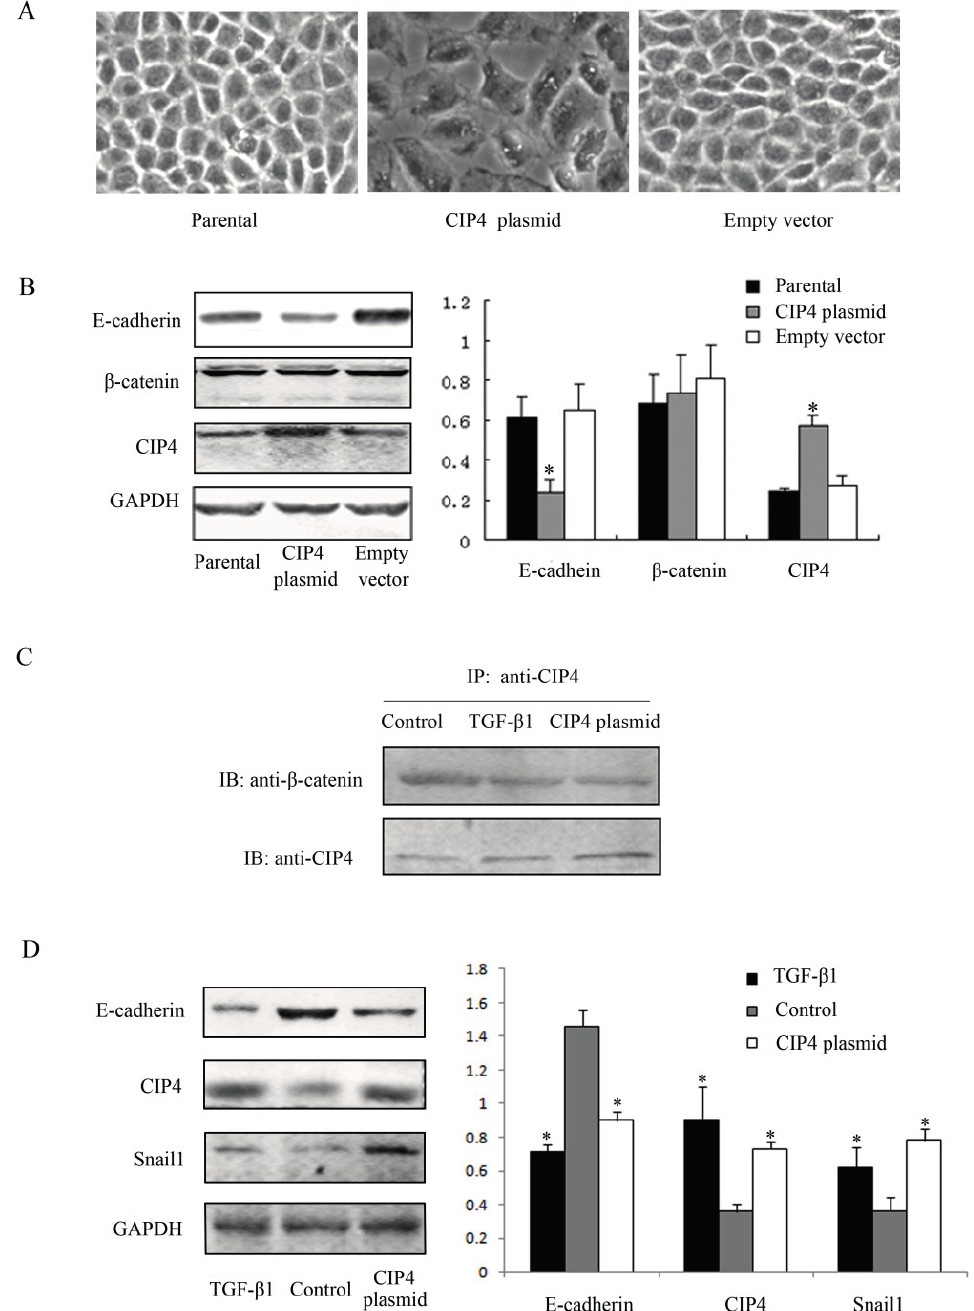
Figure 3. Overexpression of CIP4 in NRK-52E cells is accompanied by decreased expression of E-cadherin. ( A ) Morphological changes of CIP4 plasmid-transfected cells compared with parental and empty vector-transfected cells, 100×; ( B ) Western blots for protein expression of E-cadherin, β -catenin and CIP4 in parental, CIP4 plasmid-transfected and empty vector-transfected cells. The histogram shows the average volume density normalized to the loading control GAPDH ( n = 3); * p < 0.05 compared with parental cells; ( C ) Immunoprecipitation for interaction of β -catenin and CIP4; and ( D ) Western blots for protein expression of E-cadherin, CIP4 and Snail1 in TGF- β 1 treated cells, control cells and CIP4 plasmid-transfected cells. The histogram shows the average volume density normalized to the loading control GAPDH ( n = 3); * p < 0.05 compared with control